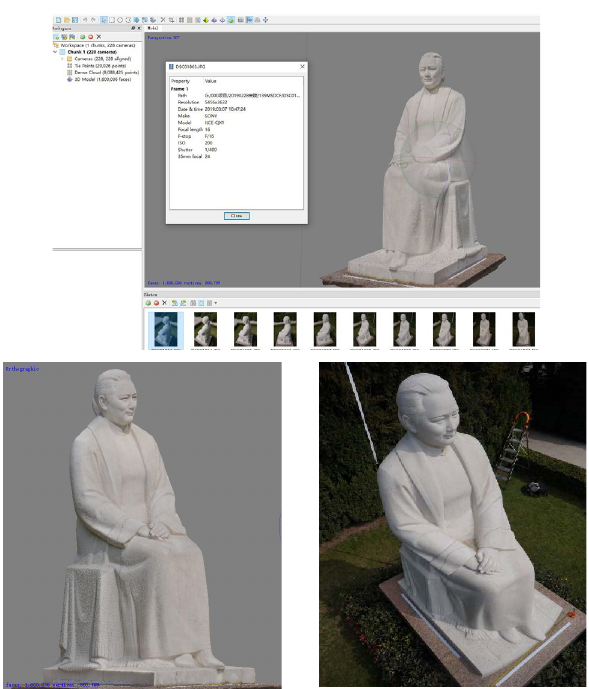
Figure 4 . 3D modelling in process and the final digital